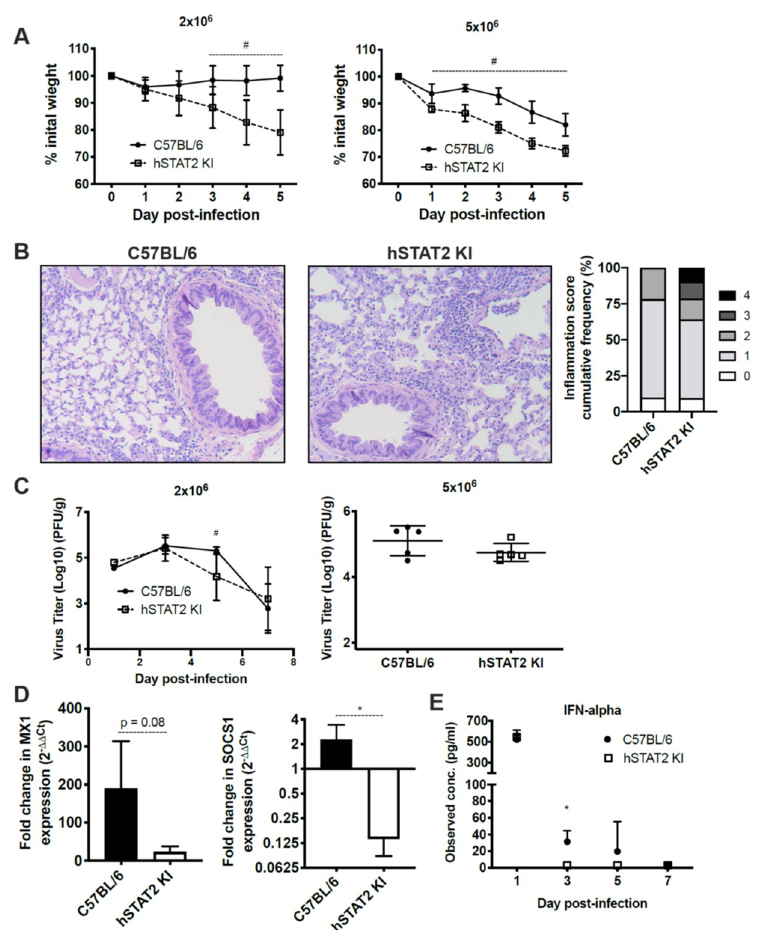
Figure 7. hSTAT2 KI mice have greater disease severity and inhibition of ISGs compared to WT mice after infection by HMPV, despite no increase in virus titer. hSTAT2 KI mice and C57BL/6 mice were intratracheally inoculated with HMPV at a low (2 × 10 6 pfu/mL) or high (5 × 10 6 pfu/mL) titer and weighed daily over the course of infection ( A ). ( B ) Lung specimens were taken at day five post-inoculation with HMPV at low titer, stained with H&E, and scored by a pathologist. Histology images were captured at 100×. Histological scoring was calculated by percentage of inflammation per field of view, with scores of 0, 1, 2 (mild/moderate) representing 0, 1–25, and 26–50%, and 3 or 4 (severe) representing 51–75 or 76–100%, respectively. The difference between WT and hSTAT2 KI mice in the frequency of mild/moderate and severe inflammation scores was statistically significant by Fisher’s